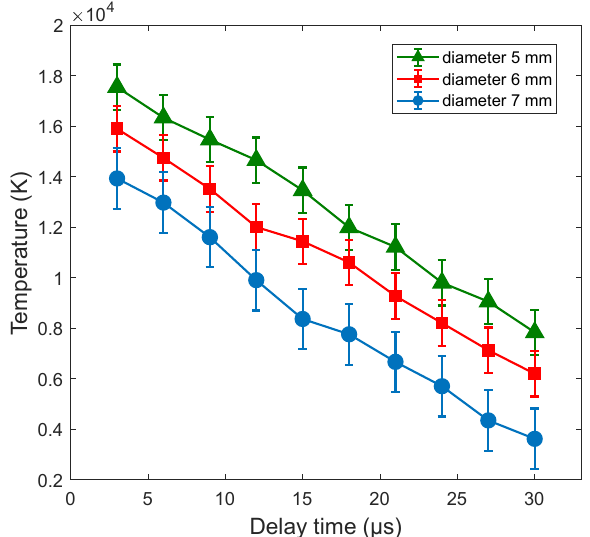
Figure 15. Time-resolved electron temperatures of the Ti plasma at different sizes of the circular cavity at a laser fluence of 23.3 J cm − 2 .